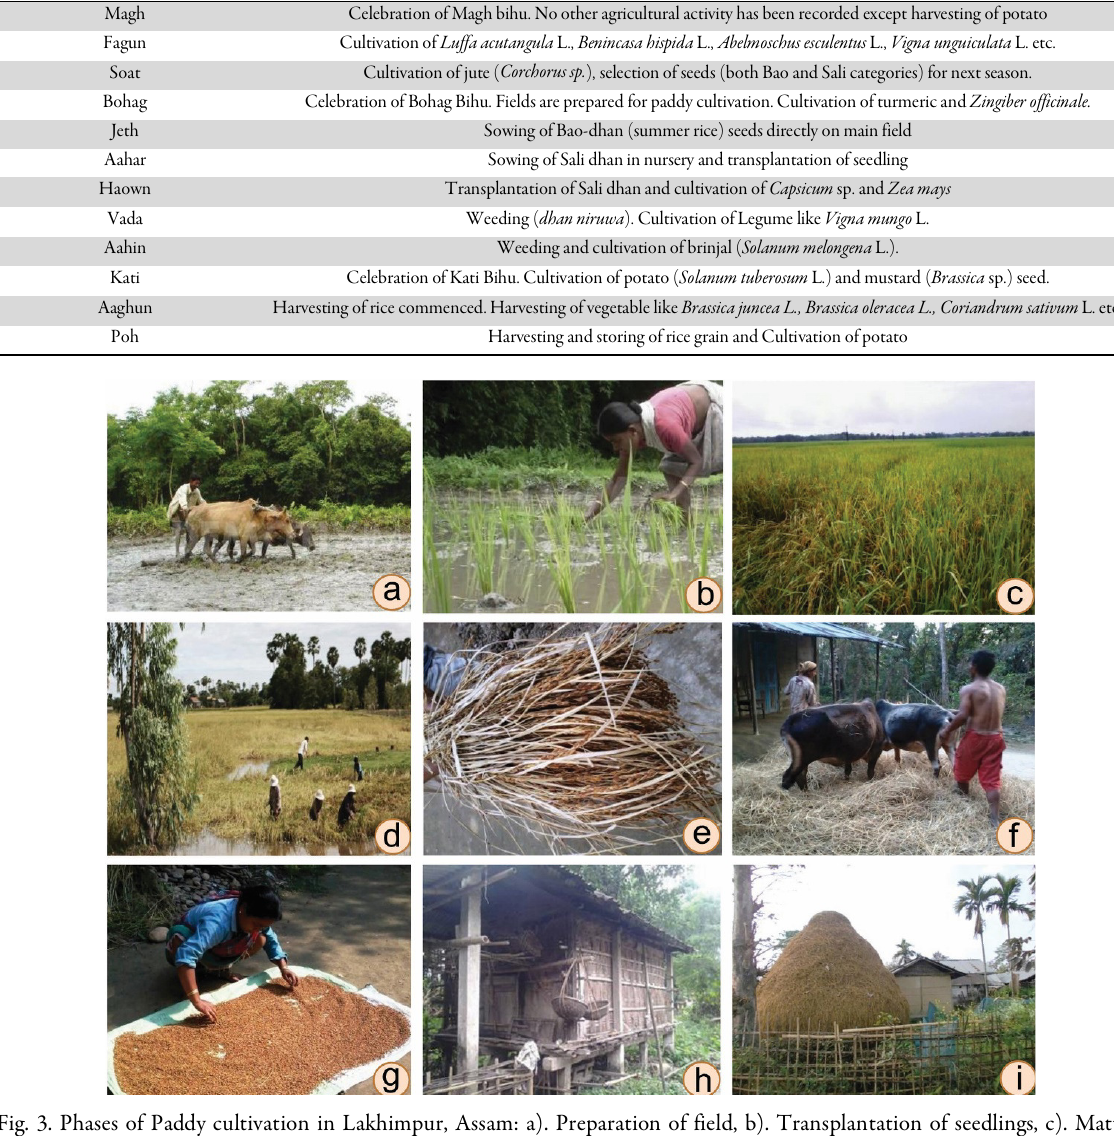
Table 2. Cropping calendar and related activities followed by farmers of Lakhimpur, Assam, India Assamese Months Activities performed by farmer